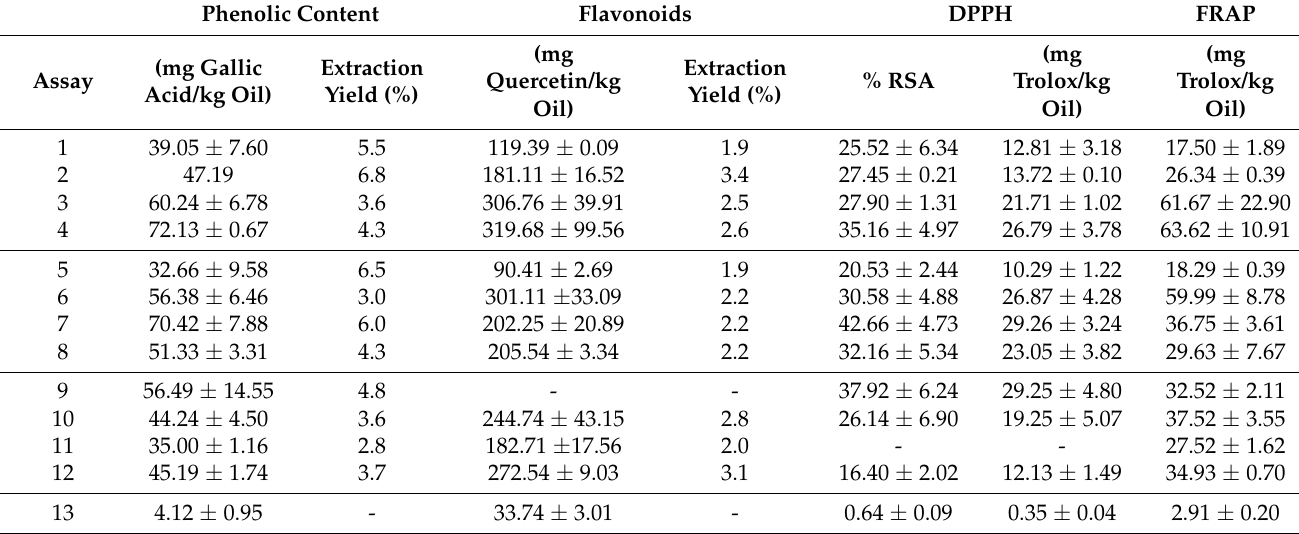
Table 4. CCRD results of phenolic and flavonoid contents, and antioxidant activity of each sam- ple of supplemented sunflower oil. Sample 13 is the original refined sunflower oil (average values ± standard deviations of three replicates). The experimental conditions of the assays are the same as presented in Table